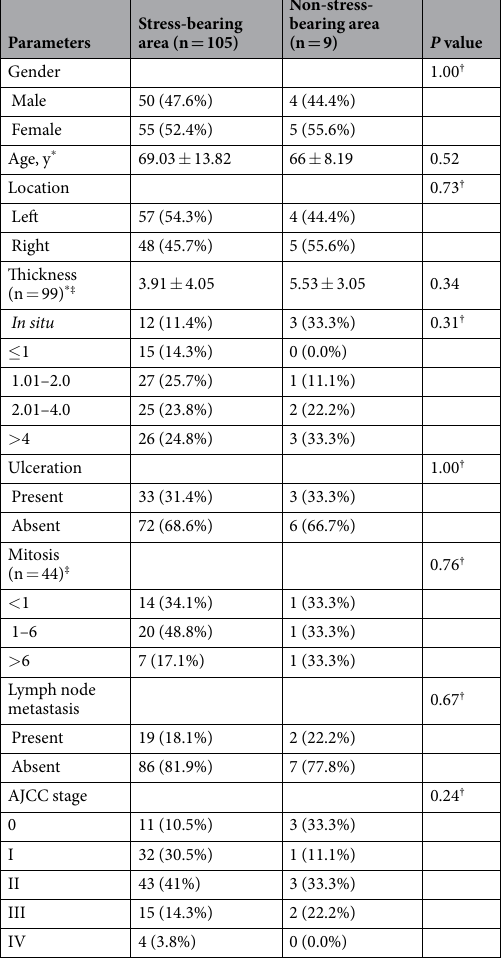
Table 2. Univariate and multivariate analyses results of risk factors associated with overall survival. CI, confidence intervals; HR, hazard ratio. * Continuous